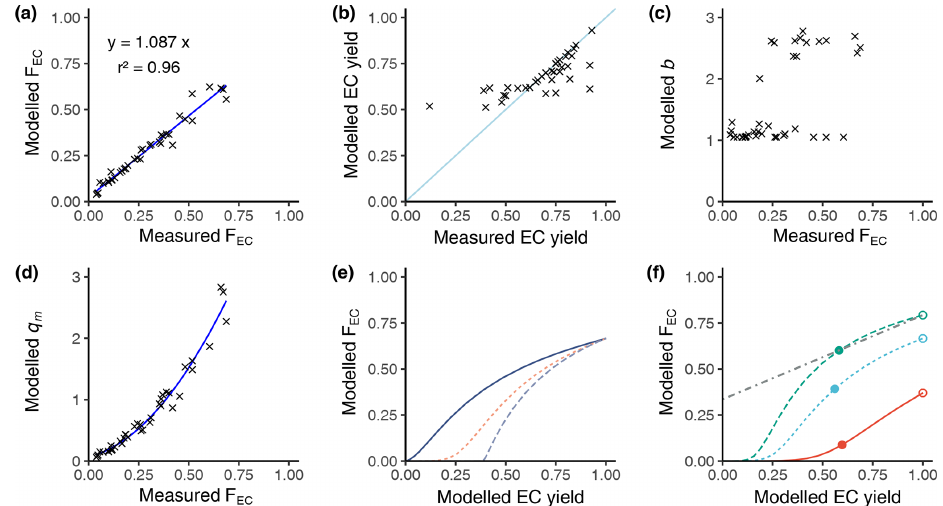
Figure 2. Summary of the modelled EC correction to an EC yield of 1. (a) Model accuracy: modelled F EC vs. measured F EC . (b) Modelled EC yield vs. measured EC yield according to Zotter et al. (2014) (see text). (c) Model calculated parameters b . (d) Model calculated parameters q m . (e) General behaviour of F EC vs. EC yield for different b values (solid line b = 1 . 1, dashed orange line b = 1 . 2, long blue line b = 1 . 5) with a fixed q m of 1.5. (f) General behaviour of F EC vs. EC yield for different q m values (solid line q m = 0 . 5, dashed green line q m = 1 . 5, dashed cyan line q m = 2 . 5) with a fixed b value of 1.2 and a linear model (dash-dotted line) for a sample with extrapolation at an EC yield of 1. Filled dots show the measured value, and the open dots show the value after